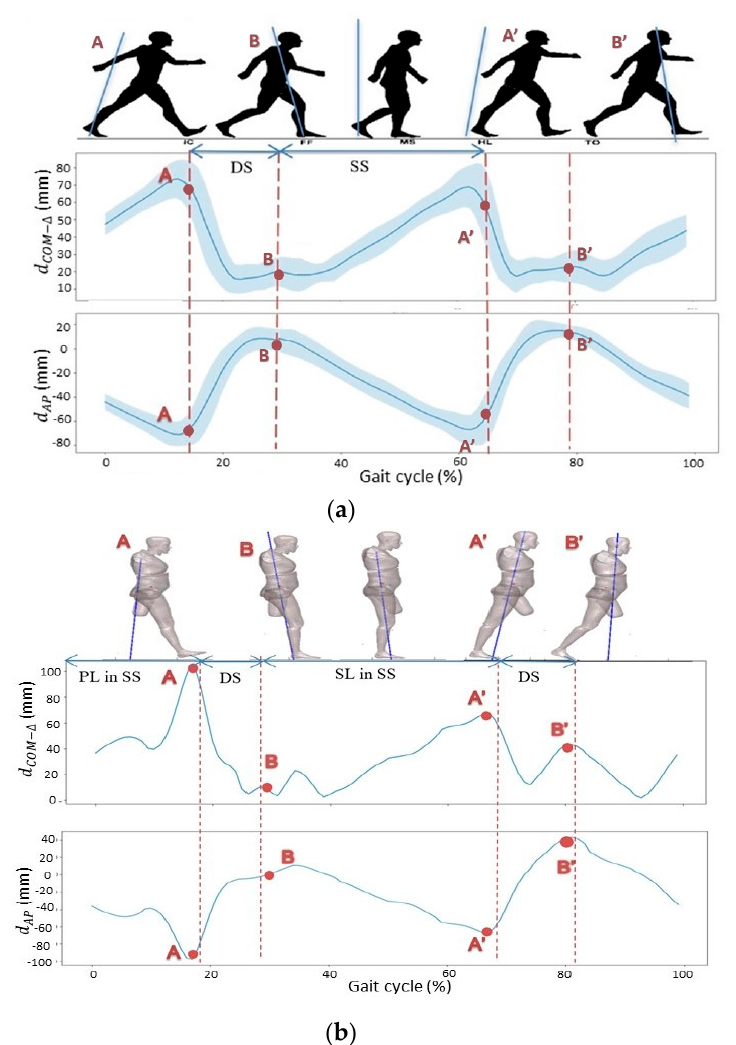
Figure 3. The plot of the distance between minimal moment axis and center of mass (COM) ( d COM − ∆ ) , and the anterior-posterior component ( d AP ) , relative to the gait cycle, for the average of healthy subjects ( a ) and an amputee subject ( b ). (A: First Heel Strike, B: First Toe O ff , A’: second Heel Strike, B’: second Toe O ff , DS: double stance, SS: single stance, PL: prosthetic limb, SL: Sound Limb).